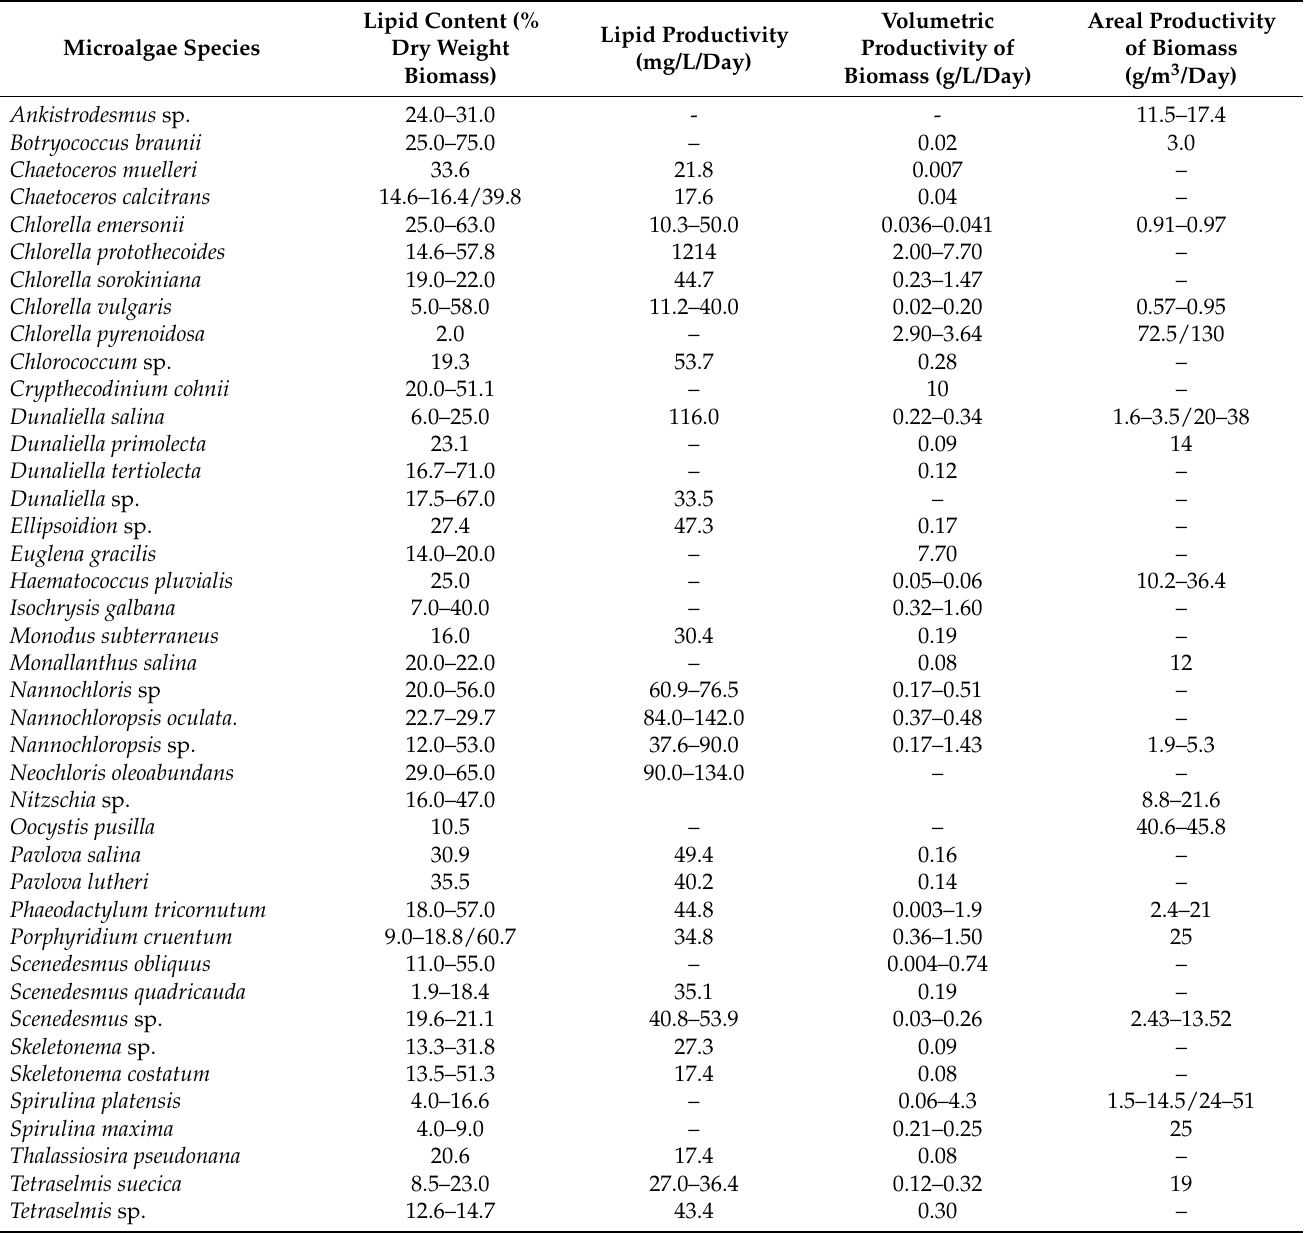
Table 2. Lipid content, lipid productivity, volumetric productivity, and areal productivity for microal- gae species